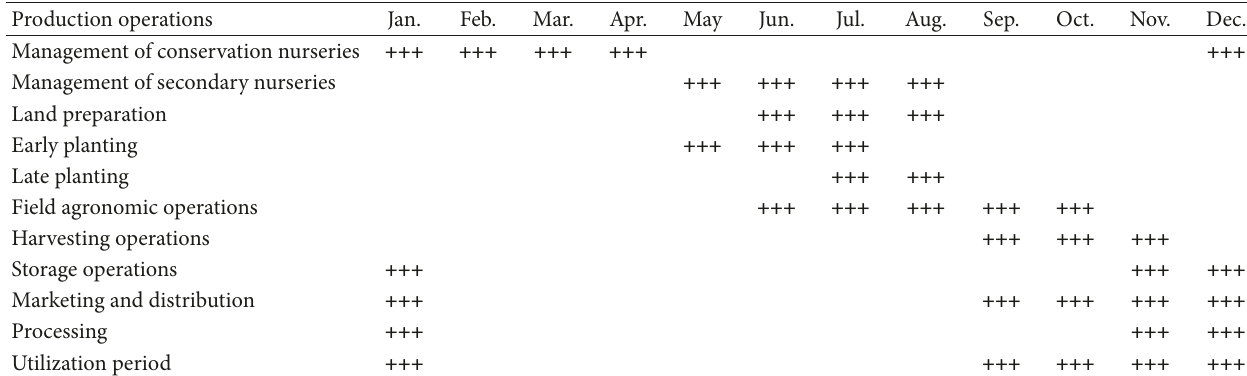
Table 2: Seasonal calendar of sweet potato production operations in Northern